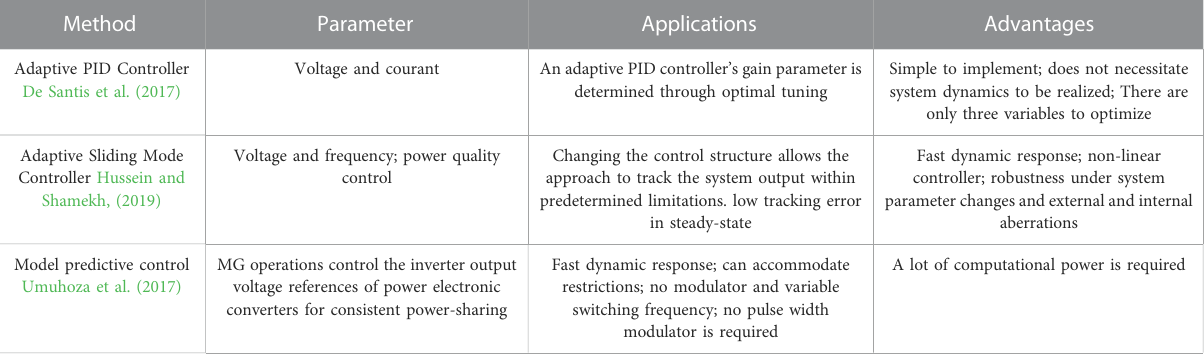
TABLE 3 Comparisons related procedures (De Santis et al., 2017; Albarakati et al., 2021)].